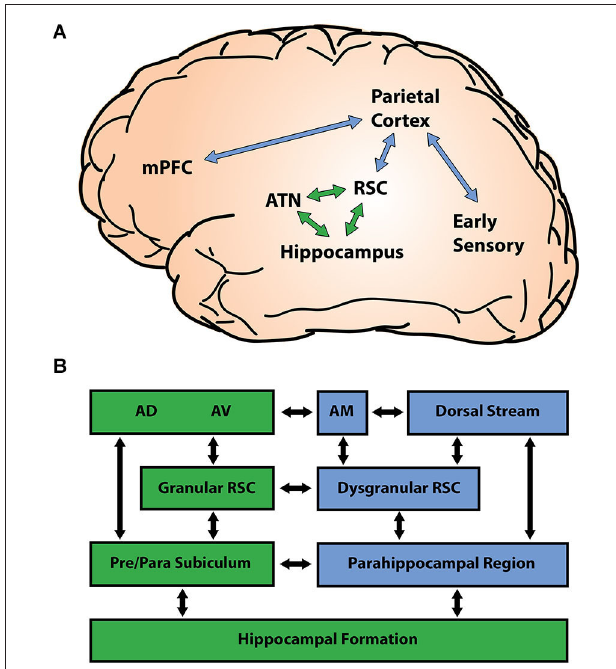
FIGURE 1 | Retrosplenial connectivity . (A) The retrosplenial cortex (RSC) is centrally positioned between cortical sensory regions (blue) and limbic memory regions (green). The parietal lobe merges information arriving from early sensory areas, and shares connectivity with both the medial prefrontal cortex (mPFC) and the RSC. Reciprocal connections between the RSC, anterior thalamic nuclei (ATN), and the hippocampus (HPC) constitute a limbic memory circuit that is essential for many forms of learning and memory. (B) The RSC shows regional differences in connectivity with limbic (green) and cortical (blue) regions. The granular RSC (areas 29a-c) shows greater connectivity with limbic regions such as the subicular cortex and the antero-dorsal (AD) and antero-ventral (AV) nuclei of the ATN, while the dysgranular RSC (area 30) shows greater connectivity with cortical regions including the parahippocampal region, the posterior parietal cortex, and early visual areas. The connections of the ATN also differ by region, with the AD and AV nuclei showing greater connectivity with limbic areas and the antero-medial (AM) nucleus showing greater connectivity with neocortical